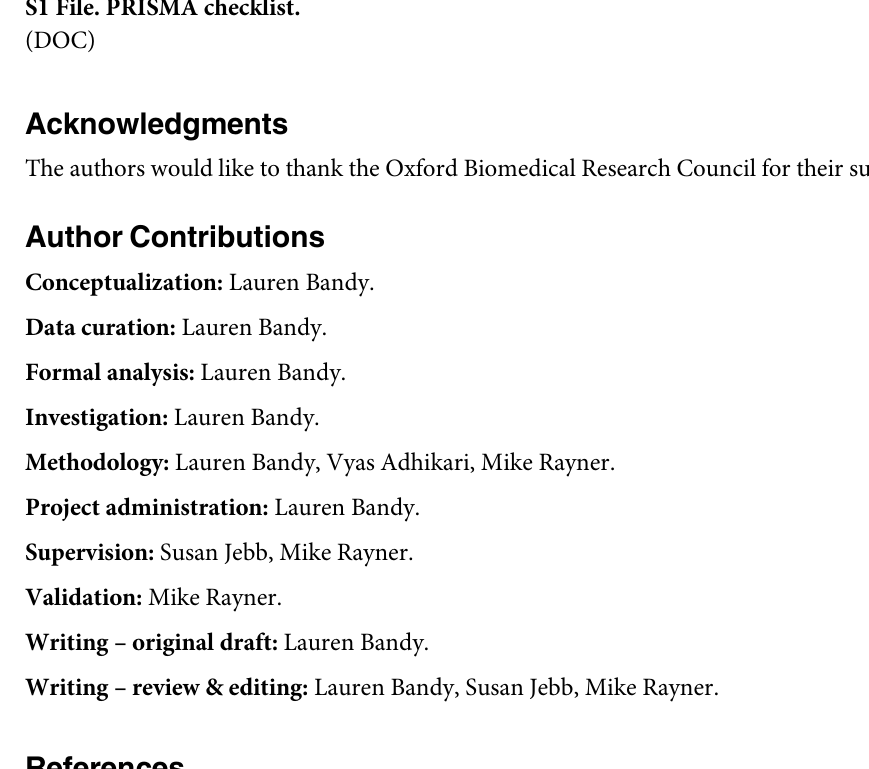
S1 Table. Summary table of included papers. Includes title, authors, objectives, data types used, variables measured and key